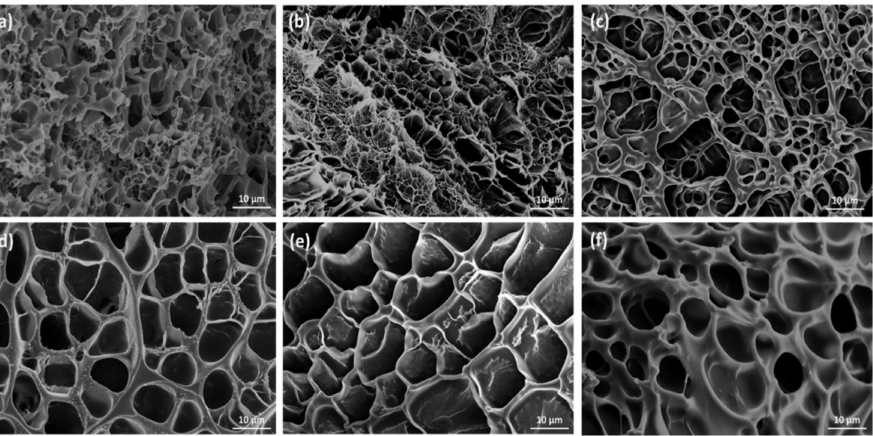
Figure 4. SEM images of the cross-sectional view of hydrogel samples. the porous structure of AA to MBAA ratio 40:1 of hydrogels ( a ) AGel, ( b ) GQDGel_0.2, and ( c ) GQDGel_0.4. and for AA to MBAA ratio 400:1 of hydrogels ( d ) AGel, ( e ) GQDGel_0.2, and ( f ) GQDGel_0.4 showing the enlarged pore